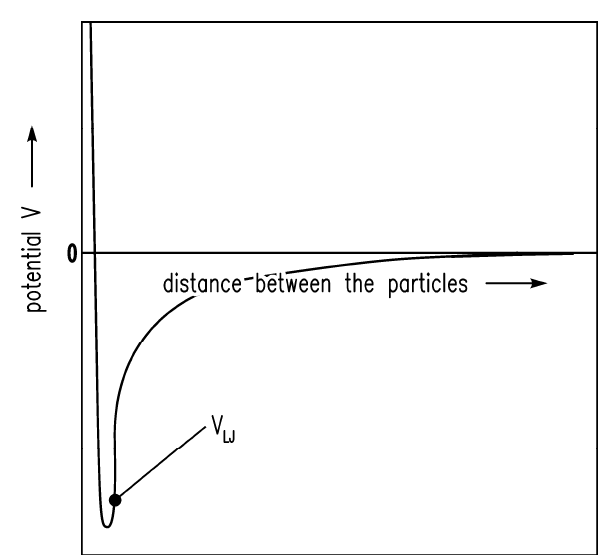
Figure 1. Lennard-Jones (12-6) potential.